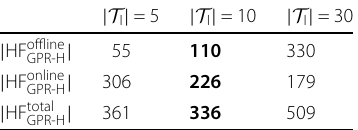
| , using batch size N I B = 50